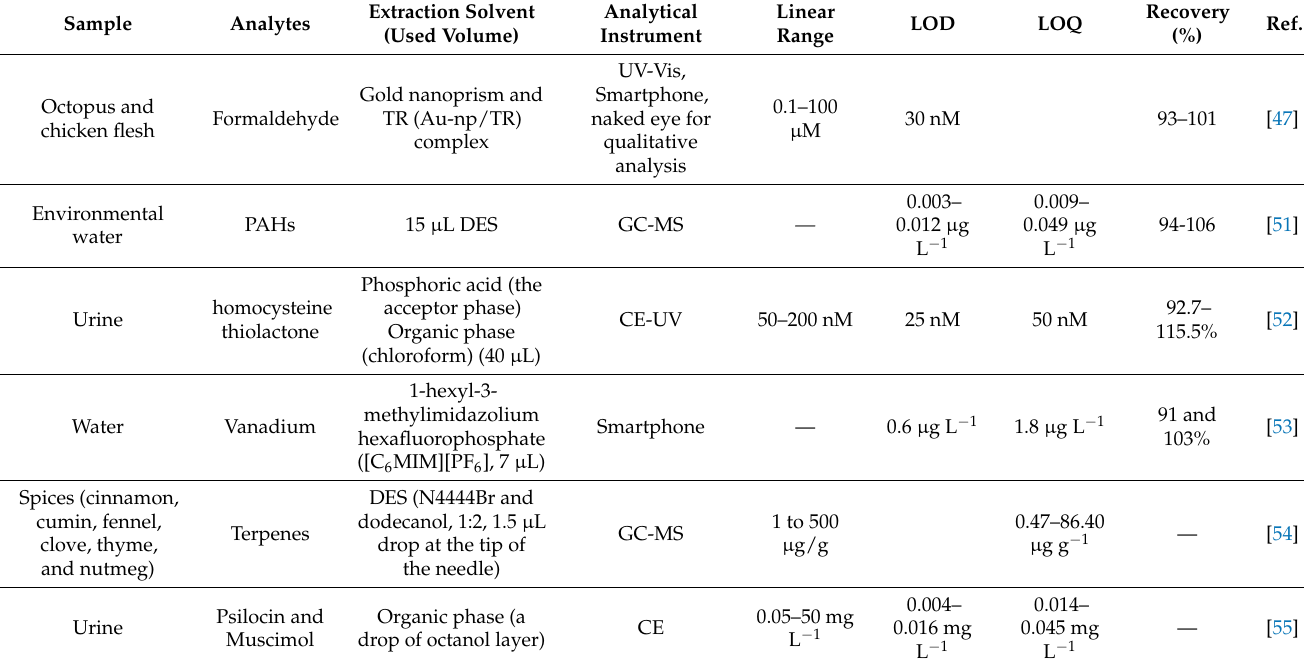
Table 2. A summary of the selected SDME